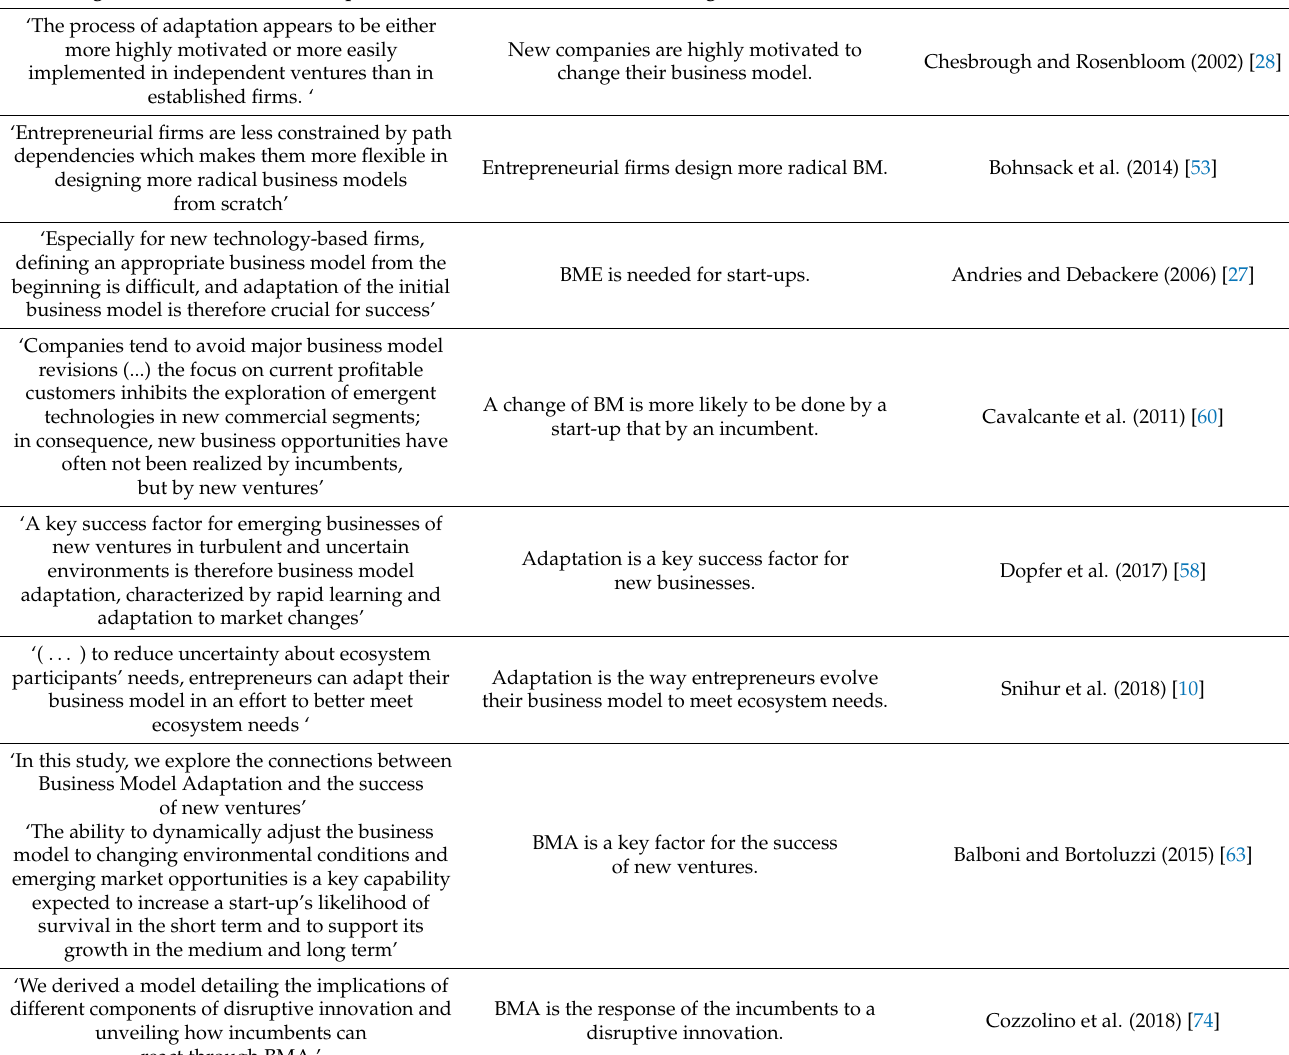
Table 11. BMA is a process for